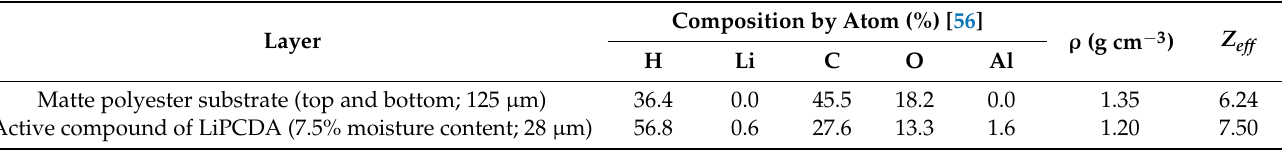
Table 2. Elemental composition and material characteristics of Gafchromic ™ EBT3